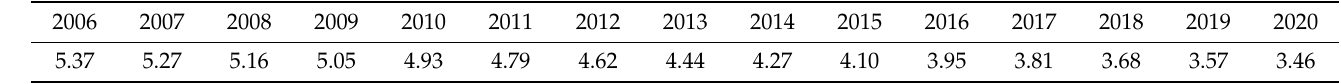
Figure 7. Prognosis of the number of people of pre-, post-, and productive age (in million) . Source: Own calculations based on Demographic situation of Poland, Central Statistical Office (2021). Table 3. Age (generation) gap (2006–2020).